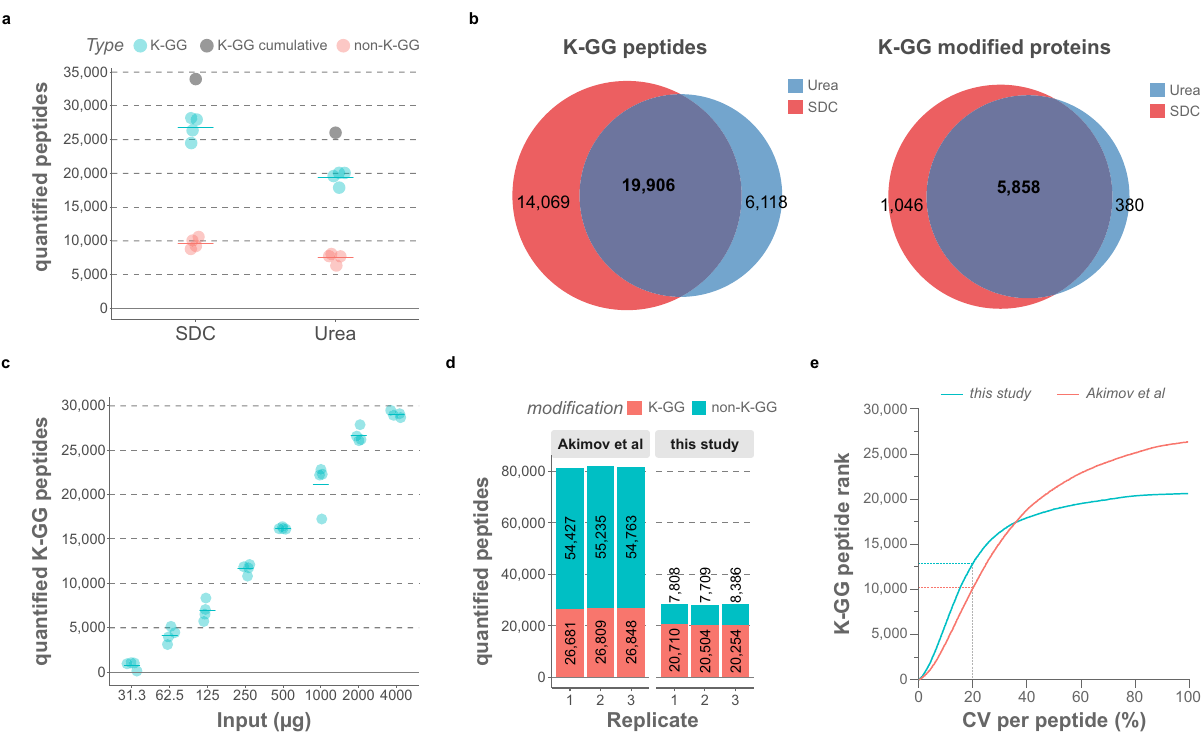
Fig. 1 Comparison of urea- and SDC-based cell lysis for mass spectrometry-based ubiquitinomics. a Fraction of unmodi fi ed and K-GG modi fi ed peptides quanti fi ed from either urea or SDC lysates in MG-132-treated HCT116 cells. Four individual samples were processed for each lysis protocol, with 2 mg of protein input per replicate. Only half of each sample was injected into the MS, which was operated in DDA mode (125 min LC gradient). The raw data were processed with MaxQuant, with “ match between runs ” (MBR) enabled. Gray dots show cumulative numbers of K-GG peptide identi fi cations from four replicates. b Overlap of quanti fi ed K-GG peptides and K-GG modi fi ed proteins with urea and SDC lysis buffers. c MS-quanti fi ed ubiquitinated peptides (K- GG remnants) with different protein inputs in MG-132-treated Jurkat cells (6 h). Four individual samples were processed for each condition and the data were acquired in single-shot mode using a 125 min DDA-MS method. The raw fi les were processed with MaxQuant, with match-between-runs (MBR) activated. d Fraction of unmodi fi ed and K-GG modi fi ed peptides quanti fi ed with the SDC-based lysis protocol and with UbiSite 19 . Three single-shot runs of enriched K-GG peptides from MG-132-treated Jurkat cells (2 mg of input, three replicates of samples as shown in c ) were processed with MaxQuant (with MBR) together with three biological replicates of bortezomib-treated Jurkat samples (16 high pH-reversed phase fractions for each replicate) from Akimov et al. e Ranked K-GG peptide coef fi cients of variation (CVs) for samples shown in d . The 20% CV cut-off is marked. Source data are provided as a Source Data fi